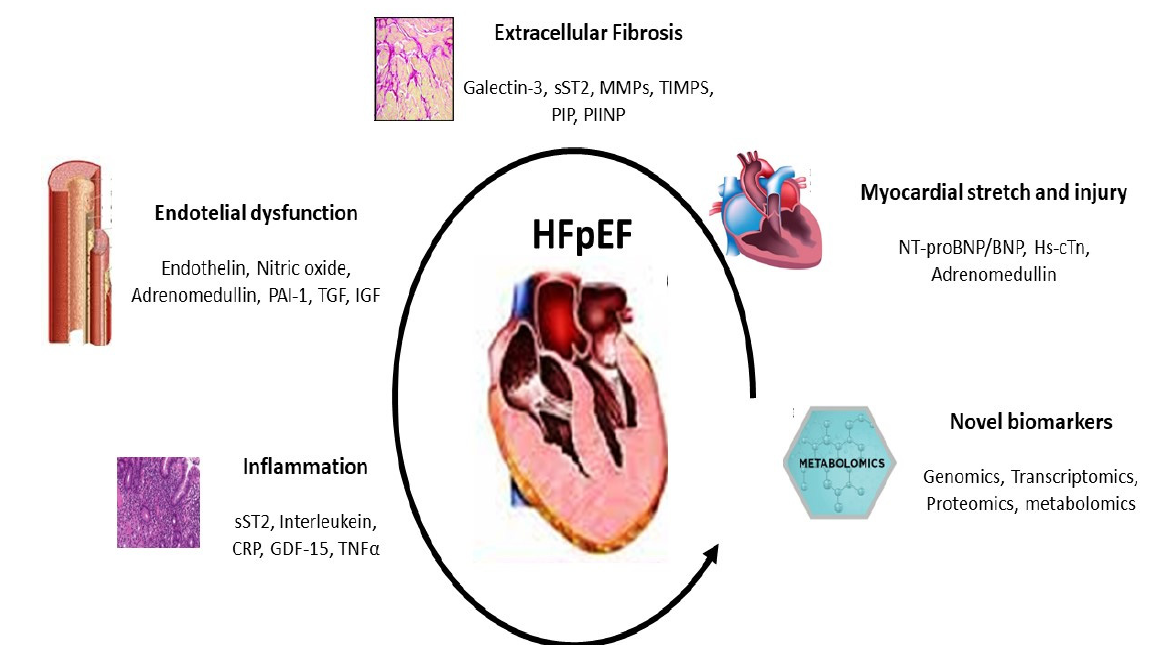
Figure 2. Potential pathophysiological mechanisms occurring in HFpEF: each disorder can be rec ‐ ognized by specific biomarker increase and overexpression. The partnership between clinical and laboratory information may better target the HFpEF